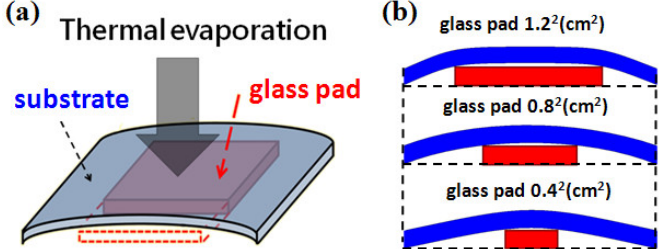
Figure 2. ( a ) Schematic diagram of substrate with glass pad underneath during thermal evaporation. ( b ) Bending geometry with glass pads in different sizes, the maximum curvature occurs around the corners of the underneath glass pad.